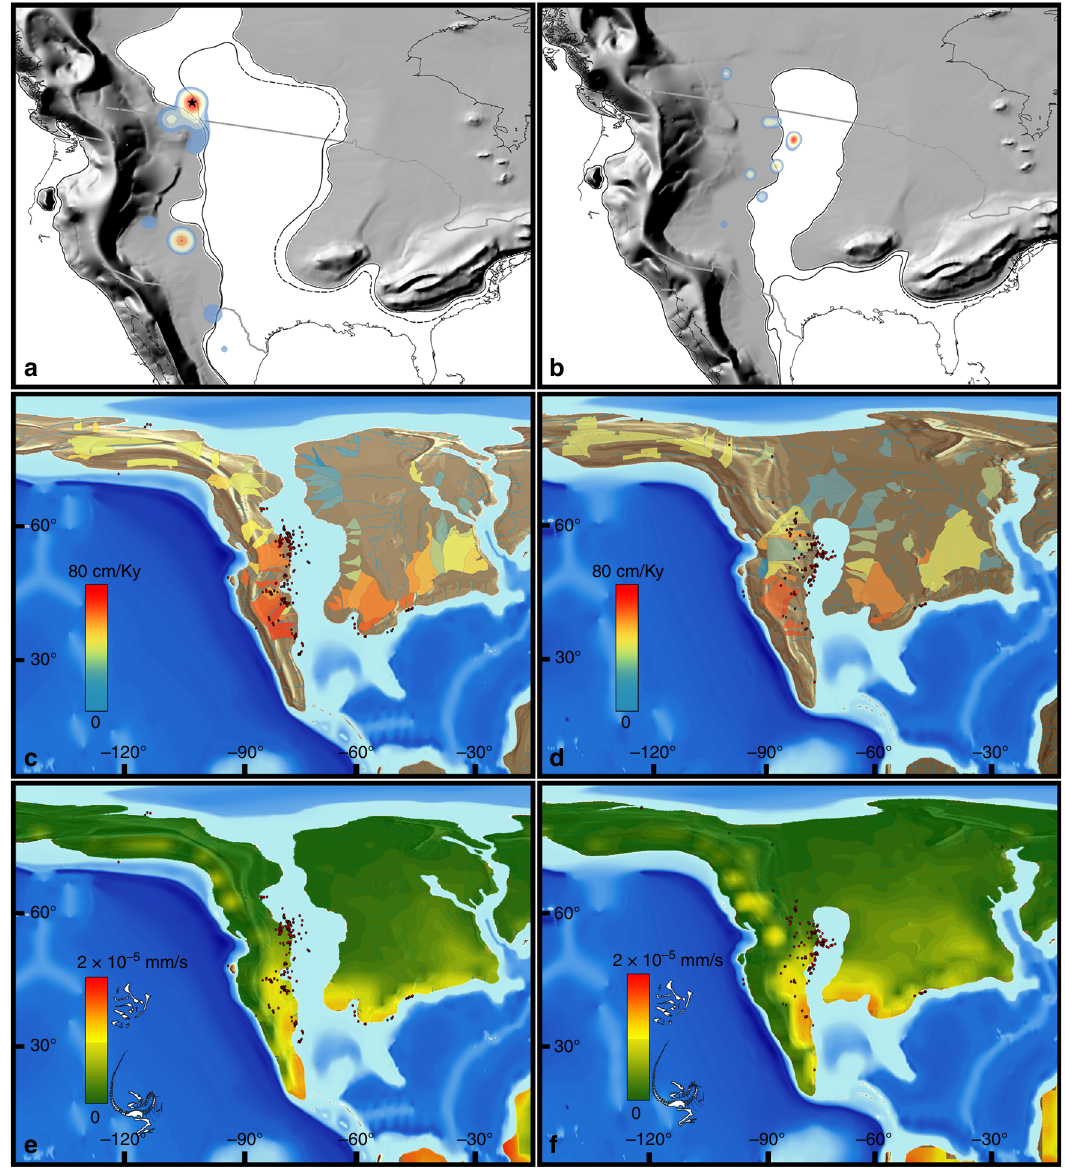
Fig. 5 Virtual taphofacies and hotspot analysis in the latest Cretaceous of North America. Kernel density in the Campanian ( a ) and Maastrichtian ( b ), with red representing highest-density and blue low-density hotspots. Grey line representing country boundaries overlaid on palaeogeographies. Black dashed line represents sea-level lowstand. Star in a is Dinosaur Provincial Park. Sediment fl uxes (cm/ky) calculated using basin drainage tools (see Methods section) in the Campanian ( c ) and Maastrichtian ( d ). Surface runoff (mm/s) models overlaid spatially in the Campanian ( e ) and Maastrichtian ( f ). Red dots represent dinosaur occurrences (data points in the middle of the Western Interior Seaway are there because they are associated with lowstand phases). Brown and grey colours represent underlying topography of the digital elevation models. Dinosaur skeletons in fi gure legends redrawn by